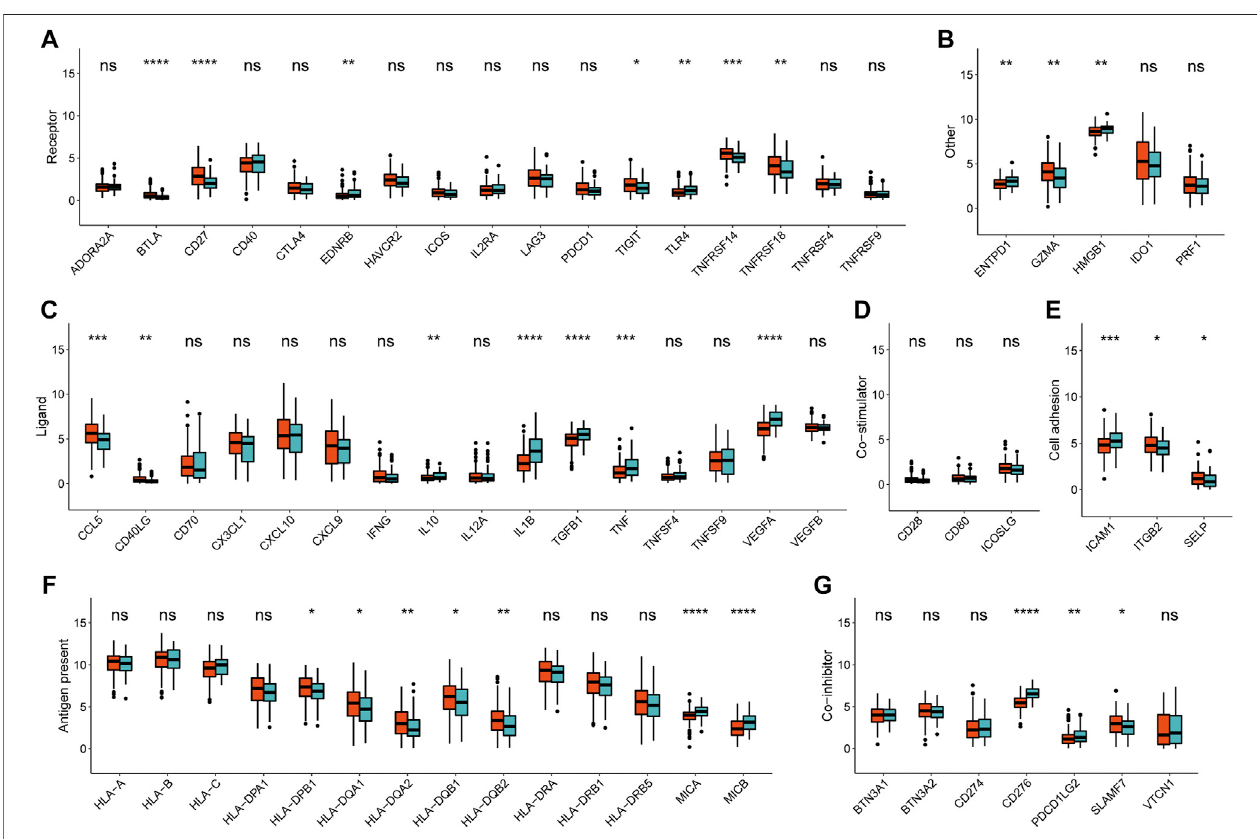
FIGURE 6 | Immune checkpoints expression (normalized count) between high- and low- METAscore groups of CESC patients. The statistical differences were determined using the Kruskal – Wallis test and the statistical p value was represented by asterisks (ns represents no signi fi cance; * p < 0.05; ** p < 0.01; *** p < 0.001; **** p <